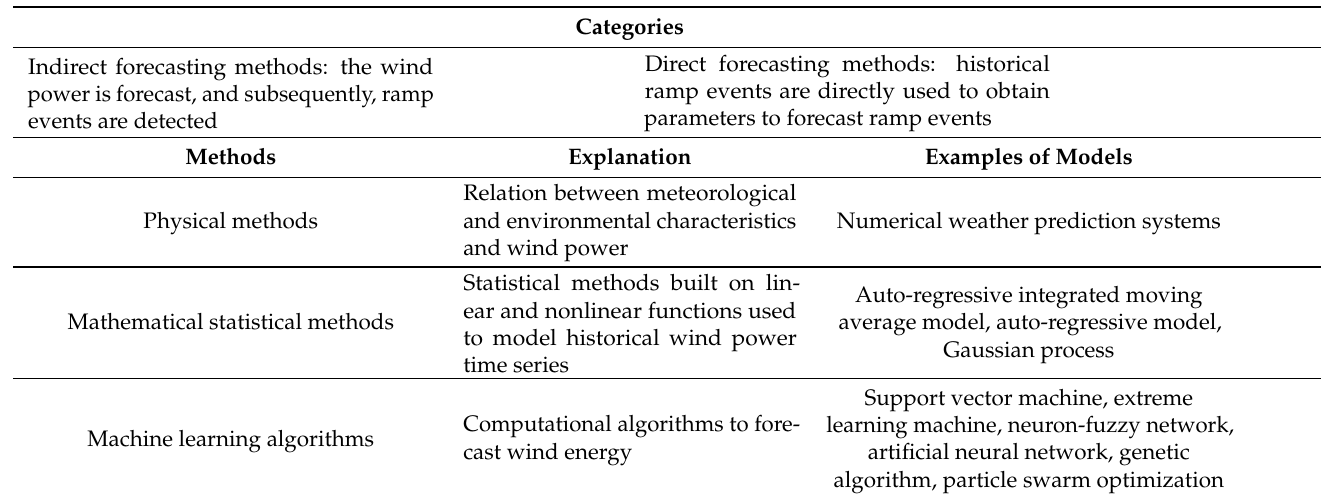
Table 1. Ramp rate prediction categories and